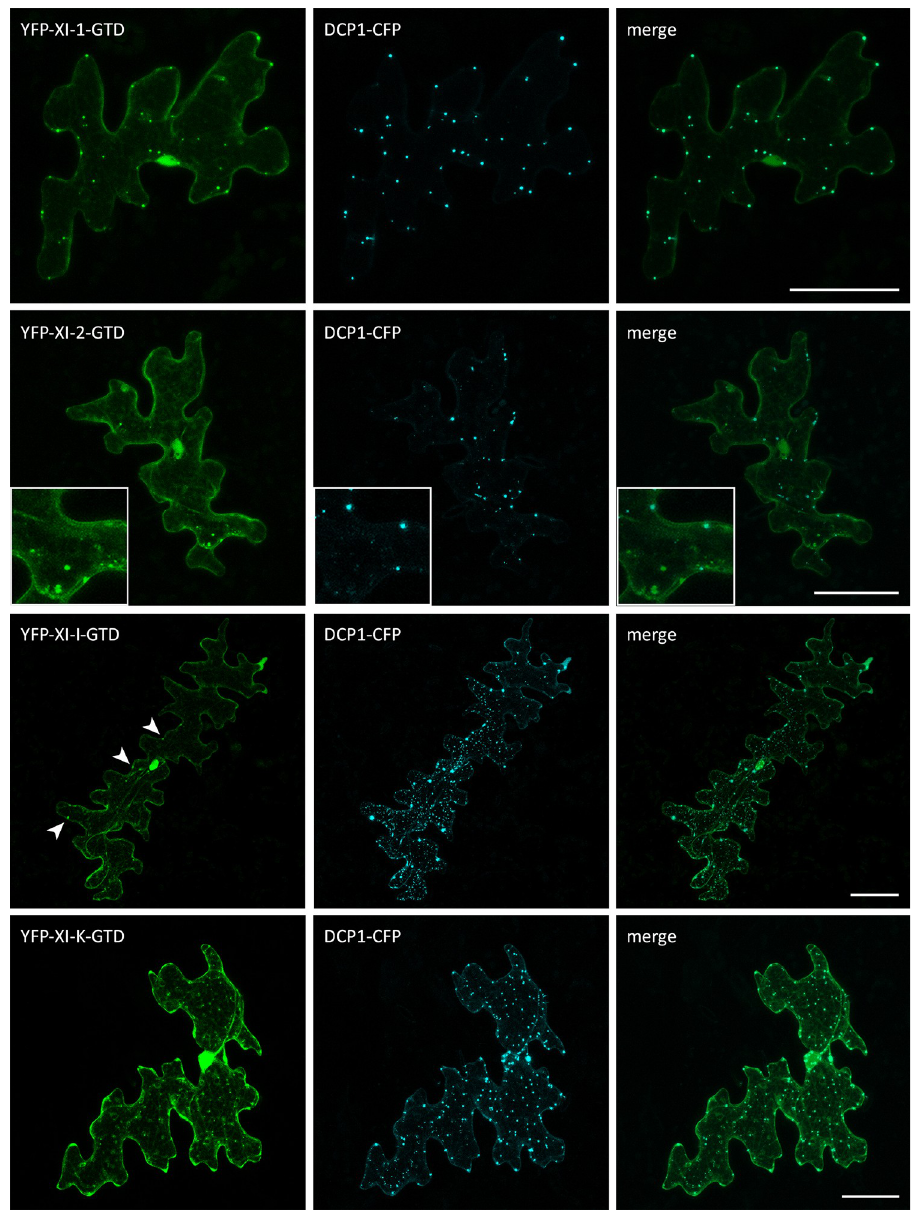
Fig 7. Co-localization of myosin GTDs and DCP1 in Arabidopsis epidermal cells. Transient expression of DCP1-CFP with myosin GTDs in Col-0 epidermal pavement cells. Arrow heads indicate dot-like structures. The scales display 50 μ